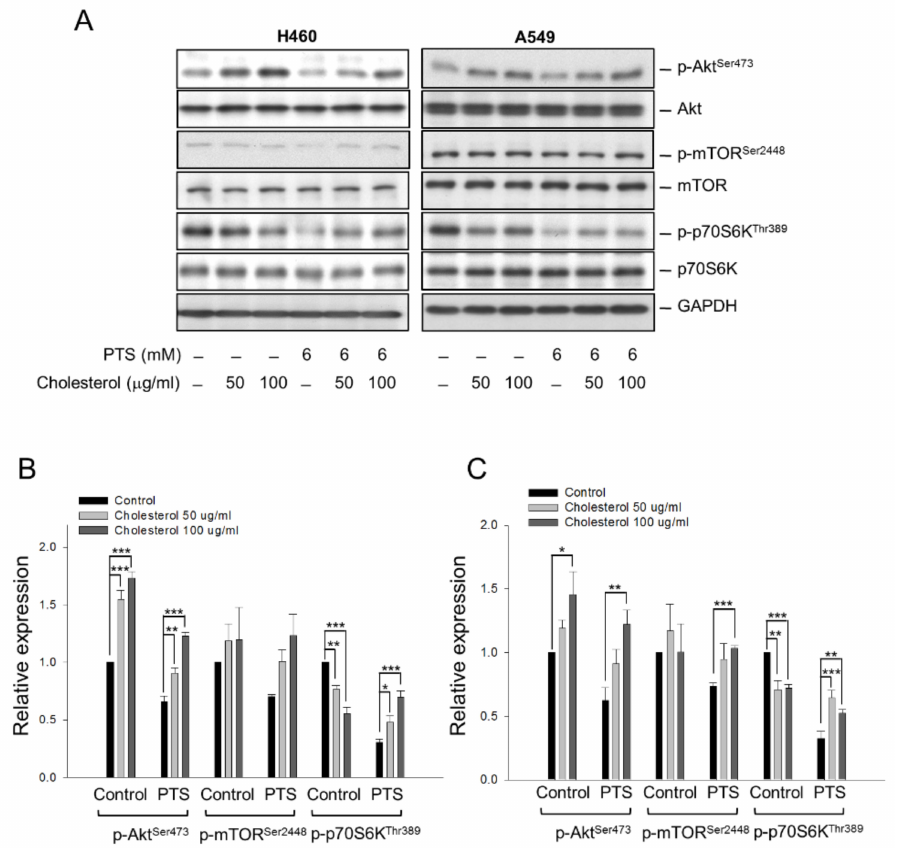
Figure 3. Effect of external cholesterol supplement on para -toluenesulfonamide-mediated effects. NCI-H460 and A549 cells were incubated in the absence or presence of the indicated agent for one hour. After the treatment, the cells were harvested and lysed for the detection of protein expressions by Western blot analysis ( A ). The expression was quantified using Image Lab Software 6.0 (BIO-RAD). The protein expression relative to para -toluenesulfonamide-free/cholesterol-free control in NCI-H460 ( B ) and A549 cells ( C ) is demonstrated. Data are expressed as mean ± SEM of three determinations. * p < 0.05, ** p < 0.01 and *** p < 0.001 compared with the